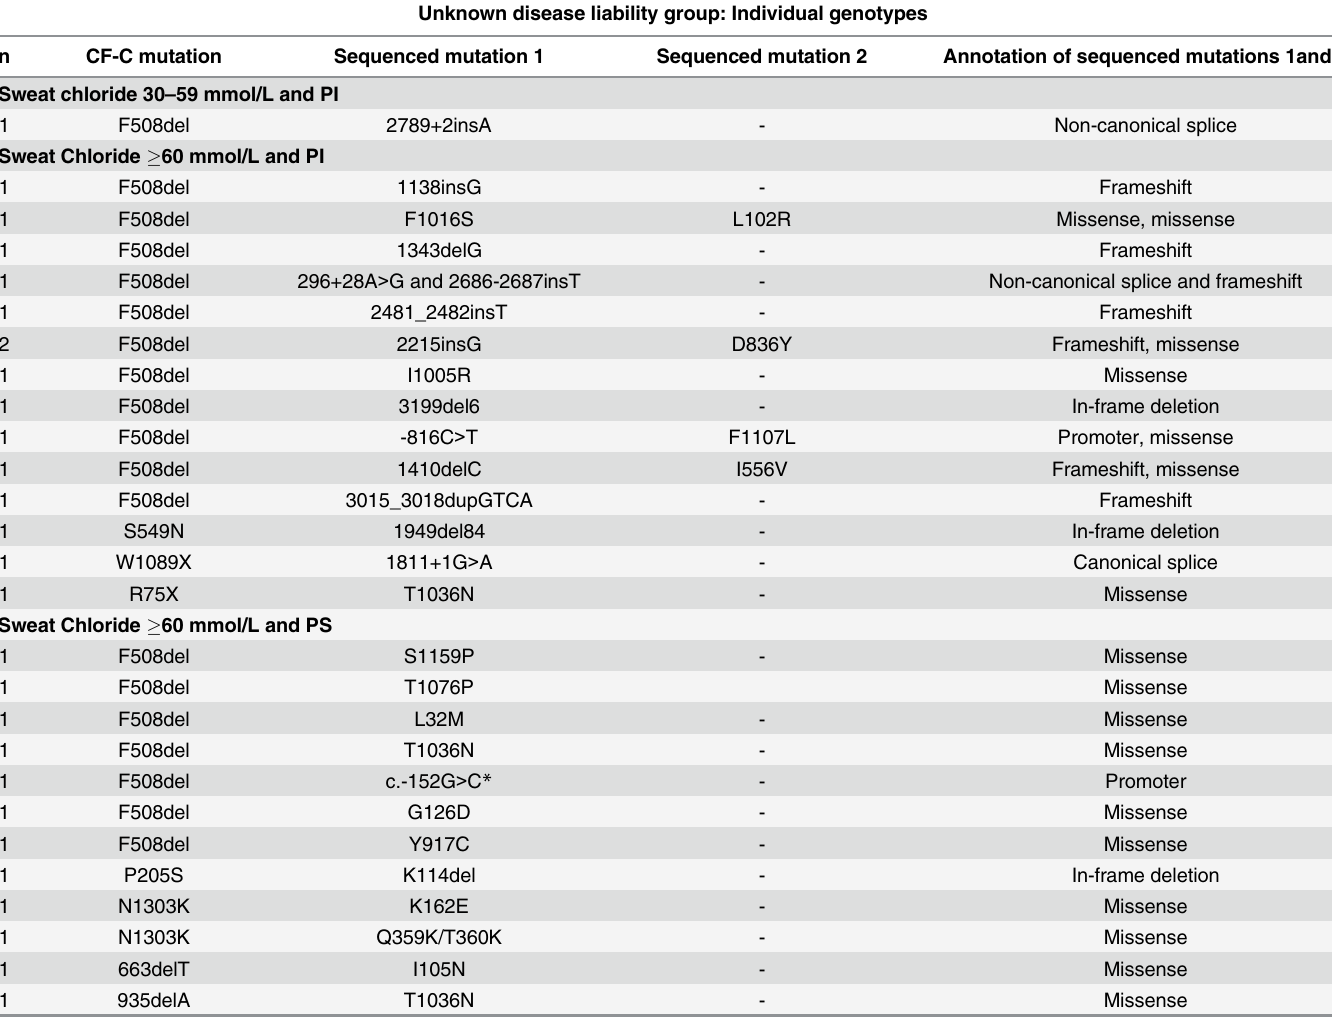
Table 2. Subjects carrying one CF-causing from the California 40 panel plus one or more sequenced mutations of unknown disease liability who met diagnostic criteria for CF based on sweat chloride levels and/or pancreatic insufficiency (PI) status. Mutations are described by legacy